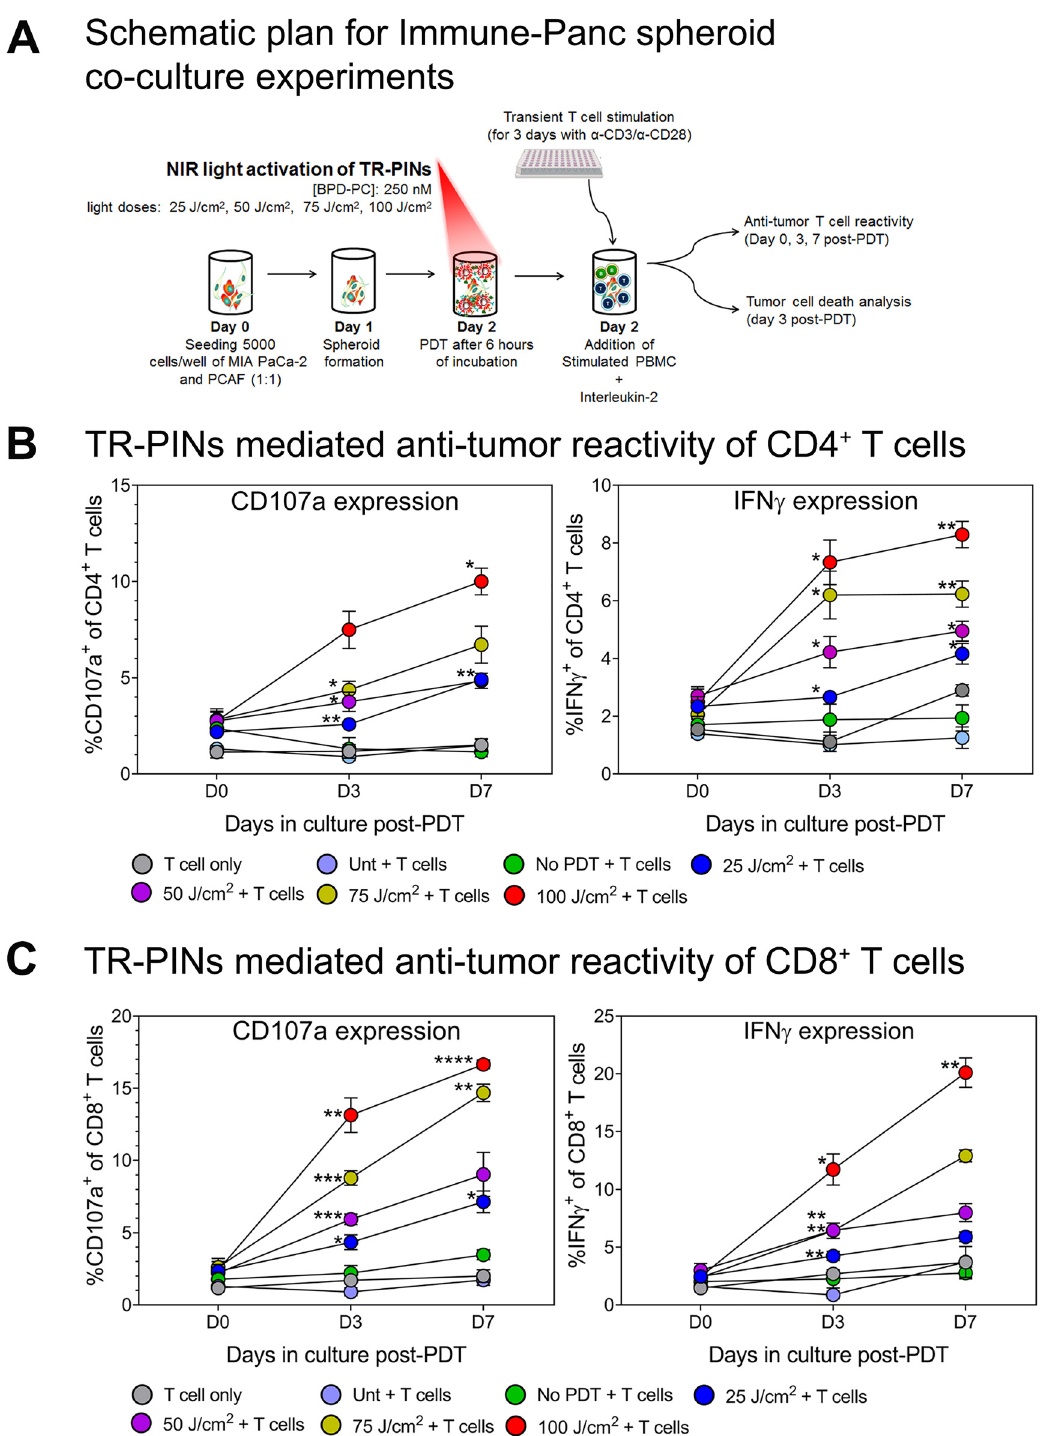
Figure 5: TR-PINs mediated priming of antitumor T cell reactivity in Immune-Panc spheroid co-cultures. (A)MIAPaCa-2andPACFswereculturedandallowedtogrowfor48hbeforeco-culturewithperipheralbloodmononuclearcells(PBMC).PBMC were seeded in 6-well plates with plate-bound anti-CD3 (overnight), anti-CD28, and IL-2, and T cells were allowed to proliferate for three days before addition to 3D spheroid cultures. This was done using a previous protocol with slight modifications [57, 58]. Once the spheroids were exposedtovaryinglightdoses,PBMCconsistingmainlyofmildlystimulatedTcellswereaddedtotheculturesandallowedtoremainforseven days. T cell priming was evaluated at day 3 and 7 post-PDT by analyzing the surface expression of degranulation marker CD107a and intracellular expression of INF γ . Also, in the same cultures, spheroid cell death was evaluated by fl ow cytometry analysis on day 3.